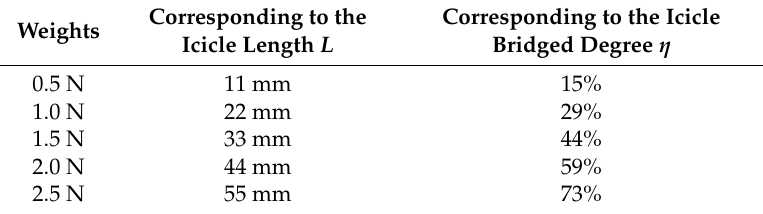
Table 4. Simulating the glaze icing load generated by an icicle with typical geometry [40]. Weights